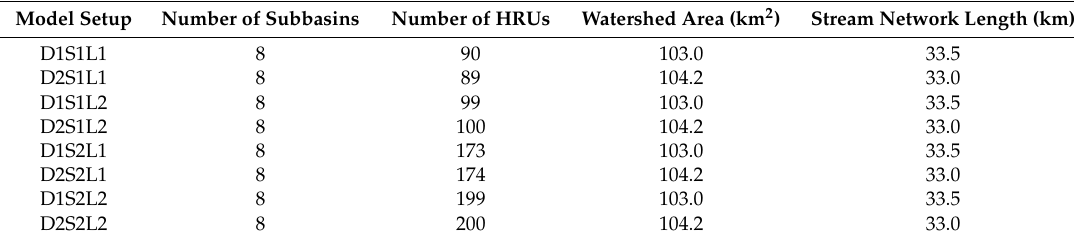
Table 1. Model setups used in the analysis.